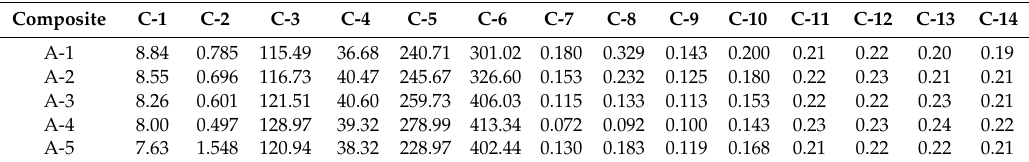
Table 3. Experimental results of the criteria.